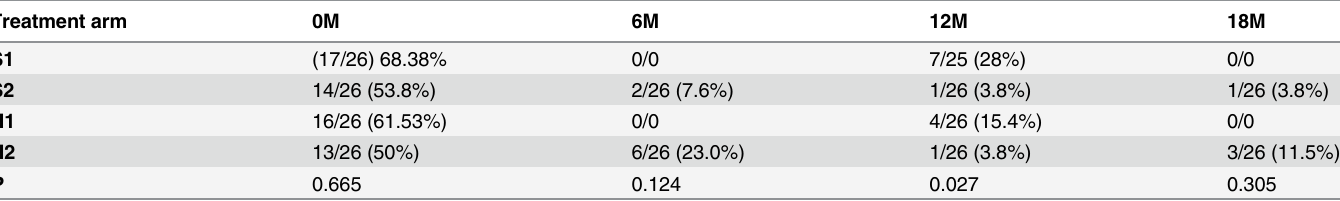
Table 10. Number and percentages of subjects showing adverse events after administration of drugs in different treatment arms. Treatment